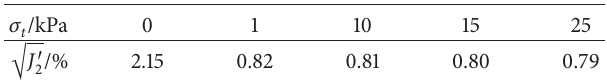
Table 3: Ultimate strain under the condition of different tensile strength.